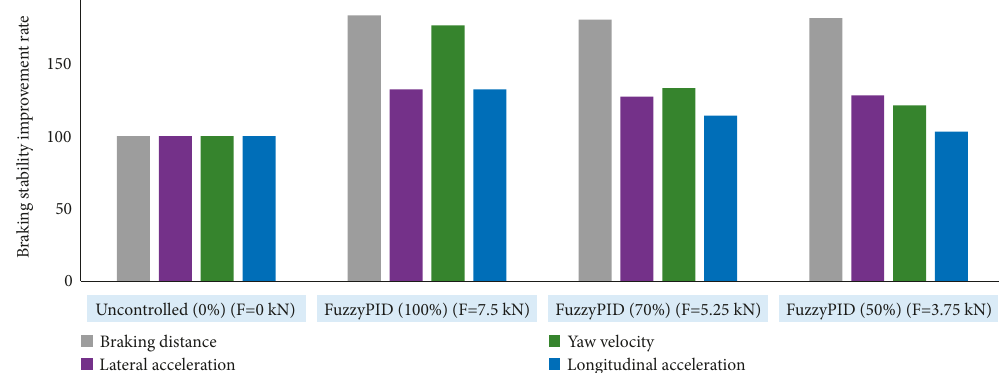
Figure 26: Fuzzy PID control in different braking efficiency improvements.